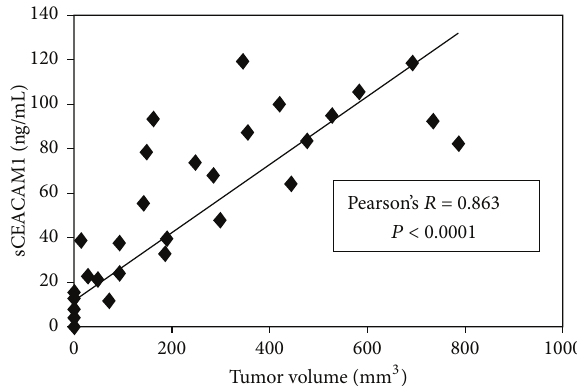
Figure 1: sCEACAM1 directly correlates with tumor burden in mice xenografts. 10 SCID-NOD mice were subcutaneously xenografted with human 009mel. Starting from the day of injection and through 3 weeks, serum samples were collected for further anti-human CEACAM1 ELISA and tumor volume was measured once weekly. The graph shows sCEACAM1 levels versus tumor